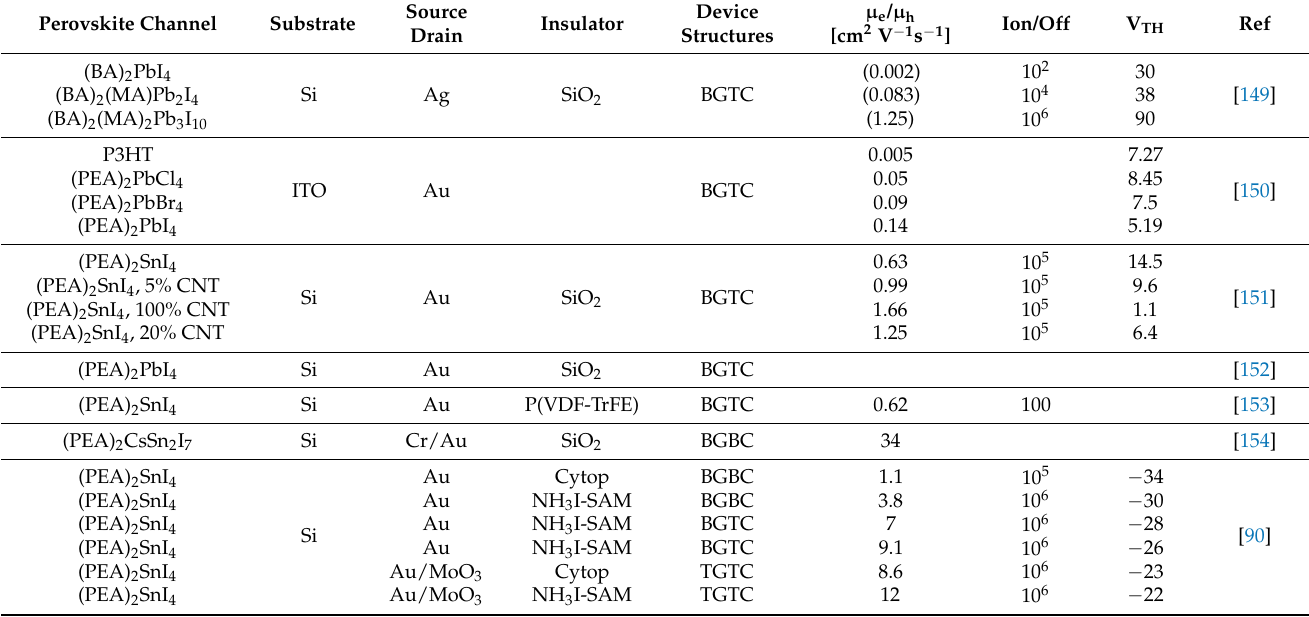
Table 4. The double and triple perovskite structured material channel based thin film FET studies in the literature after